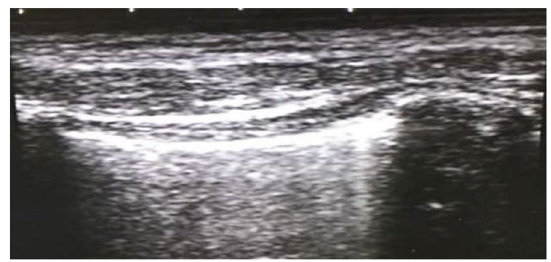
Fig. 3 Sliding lung sign